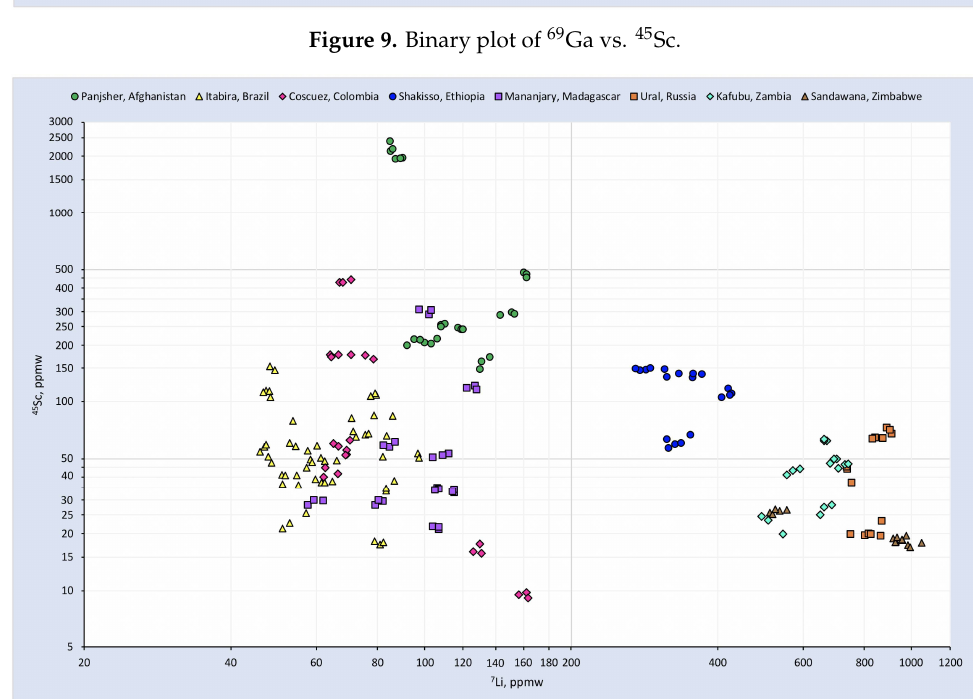
Figure 10. Binary plot of 7 Li vs. 45